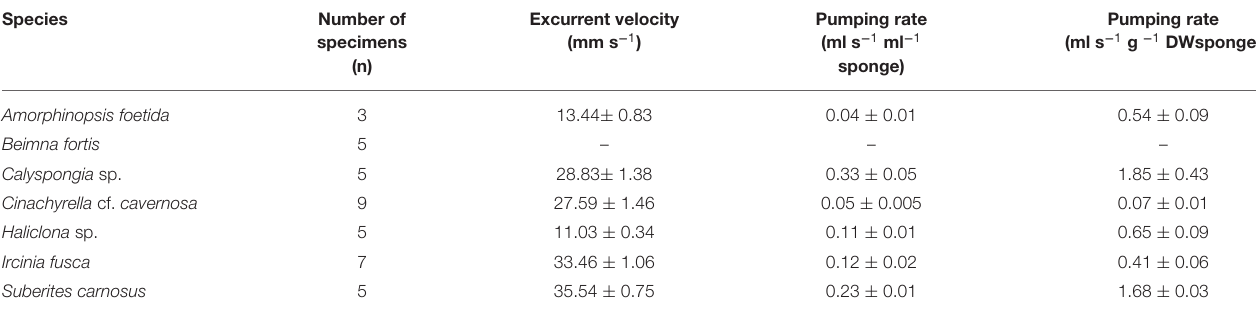
TABLE 1 | Mean excurrent velocity and pumping parameters of the studied species. Species